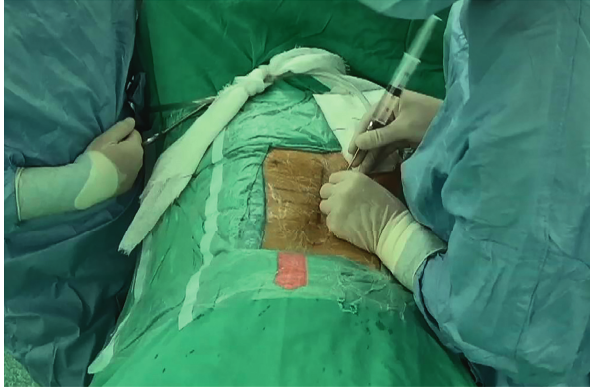
Figure 1: Epidural anesthesia before the